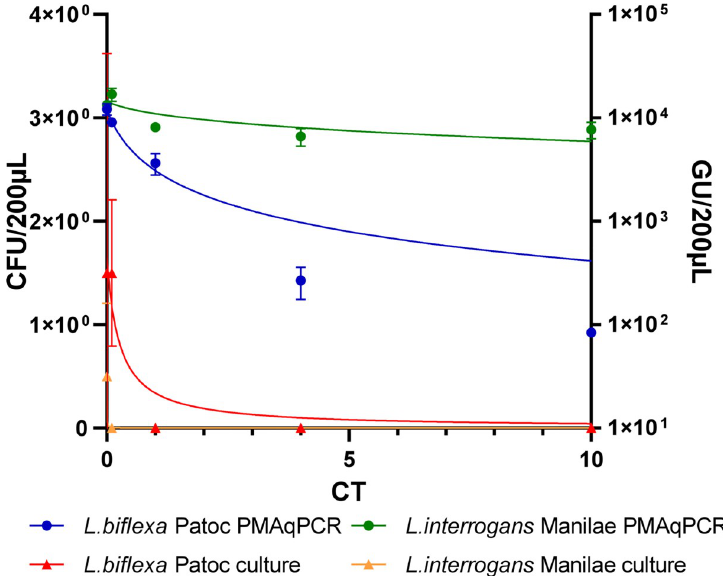
Fig 6. Chlorine inactivation for L . biflexa serovar Patoc and L . interrogans serovar Manilae by culture and PMAqPCR. Results were gathered for the two strains L . biflexa serovar Patoc (blue, red) and L . interrogans serovar Manilae (green, orange). The X-axis indicates the CT value: powerful oxidant concentration (mg/L) � time (min) of exposure. The left Y-axis represents the median bacterial culture results (in colony-forming units) after several days of incubation in EMJH semi-solid medium at 30˚C (triangle). The right Y-axis represents the median PMAxxqPCR results (in genome units) after extraction and molecular biology assay based on the 16S gene (circle).